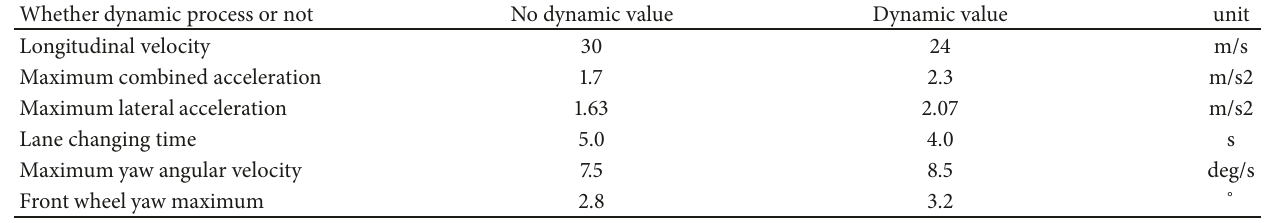
Table 2: Comparison of model parameters.